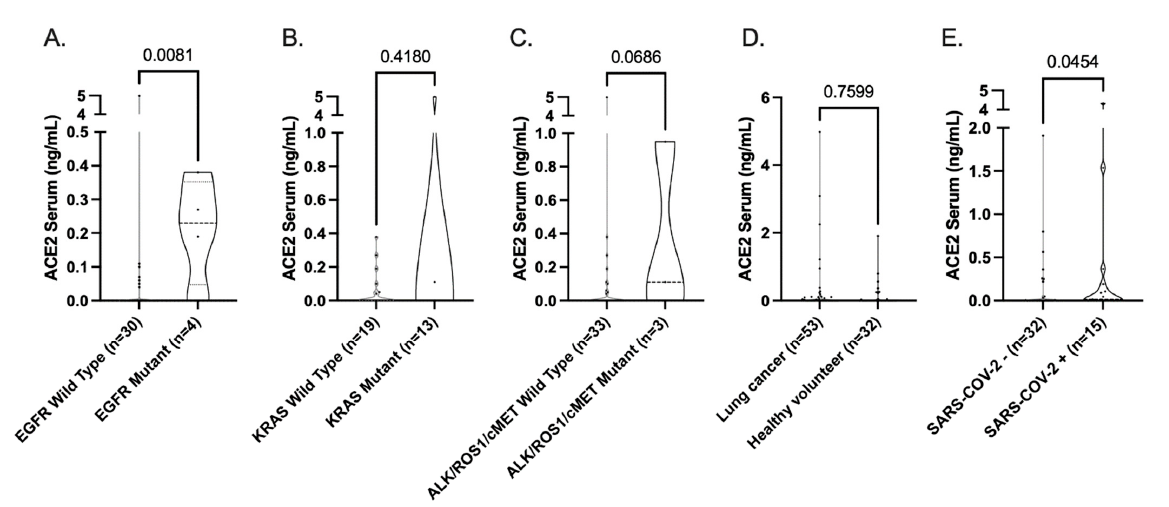
Figure 4. sACE2 levels . ( A – C ) sACE2 levels in NSCLC adenocarcinoma patients grouped by EGFR ( n = 34), KRAS ( n = 32), and ALK/ROS1/cMET mutation ( n = 36). ( D ) Comparison of sACE2 levels between SARS-CoV-2 negative lung cancer patients and healthy volunteers. ( E ) Comparison of sACE2 levels between SARS-CoV-2-negative and -positive non-cancer volunteers. Differences in expression levels were determined by Mann–Whitney U statistical analysis, with p < 0.05 indicating significance.